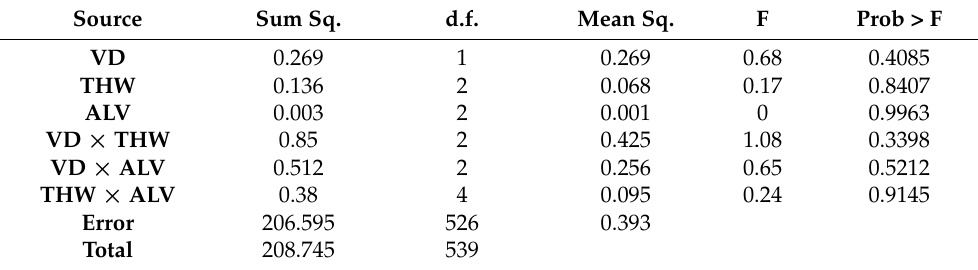
Table 3. Three-way ANOVA results on takeover reaction